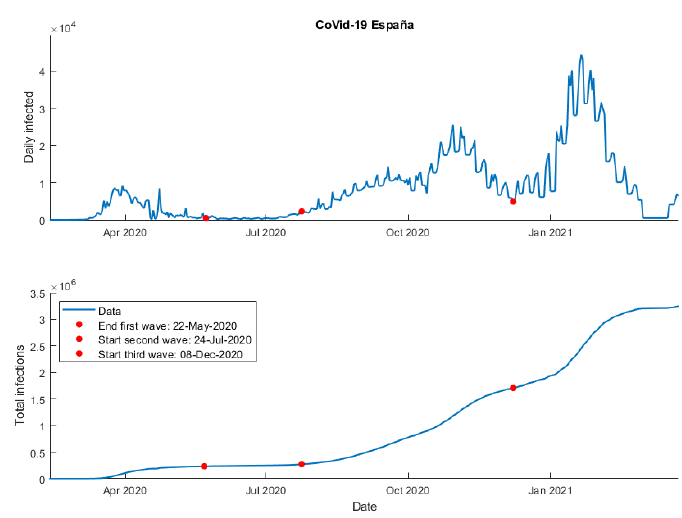
Figure 3. Data COVID-19 Spain (Updated: 25 March 2021).